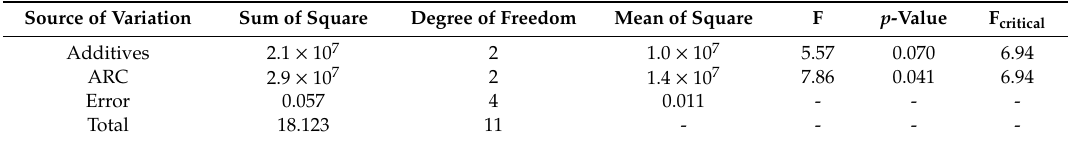
Table 11. ANOVA Results for Dynamic